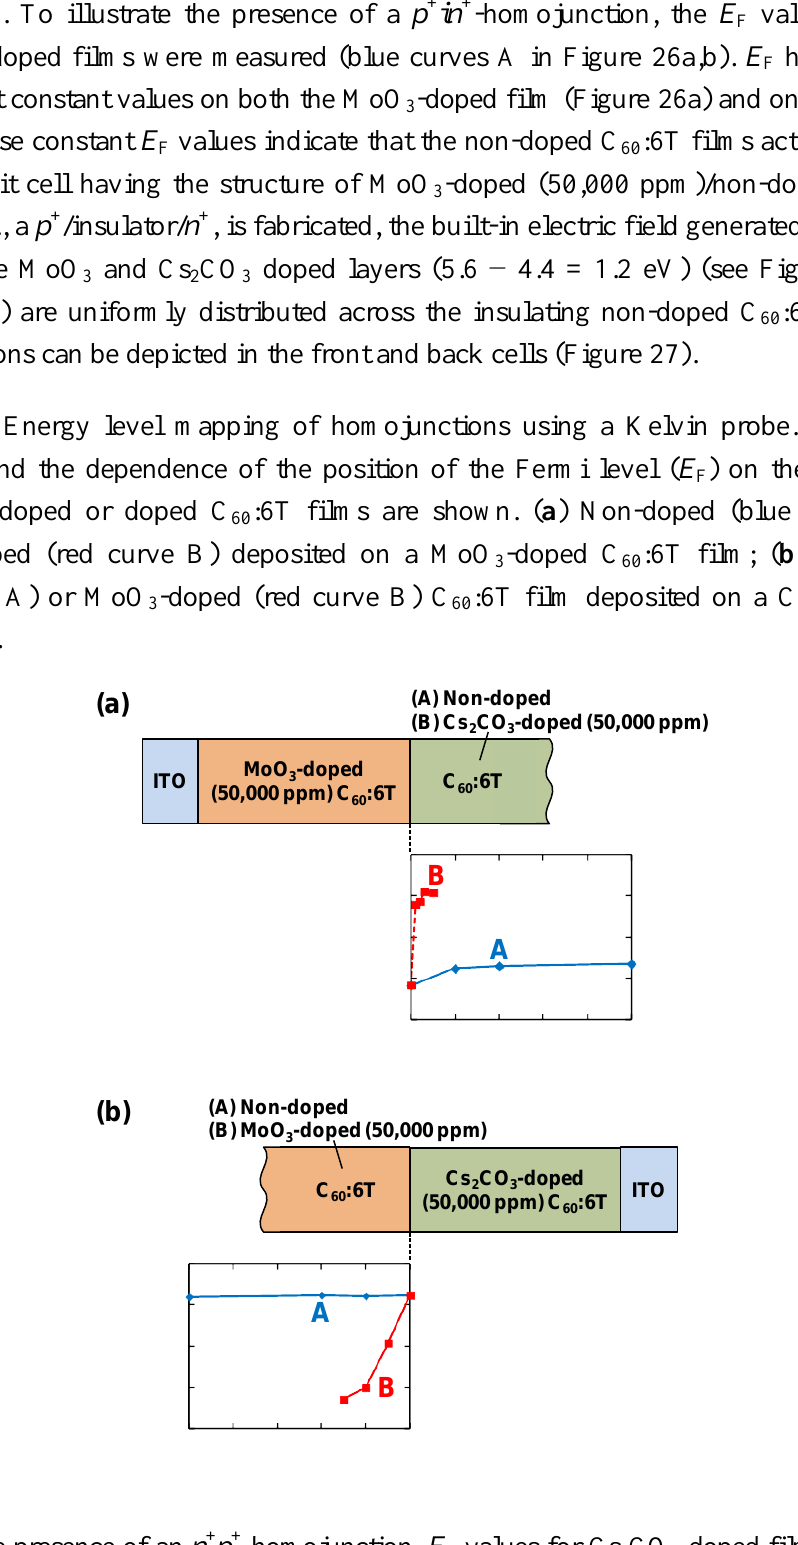
:6T film; ( b ) Non-doped 60